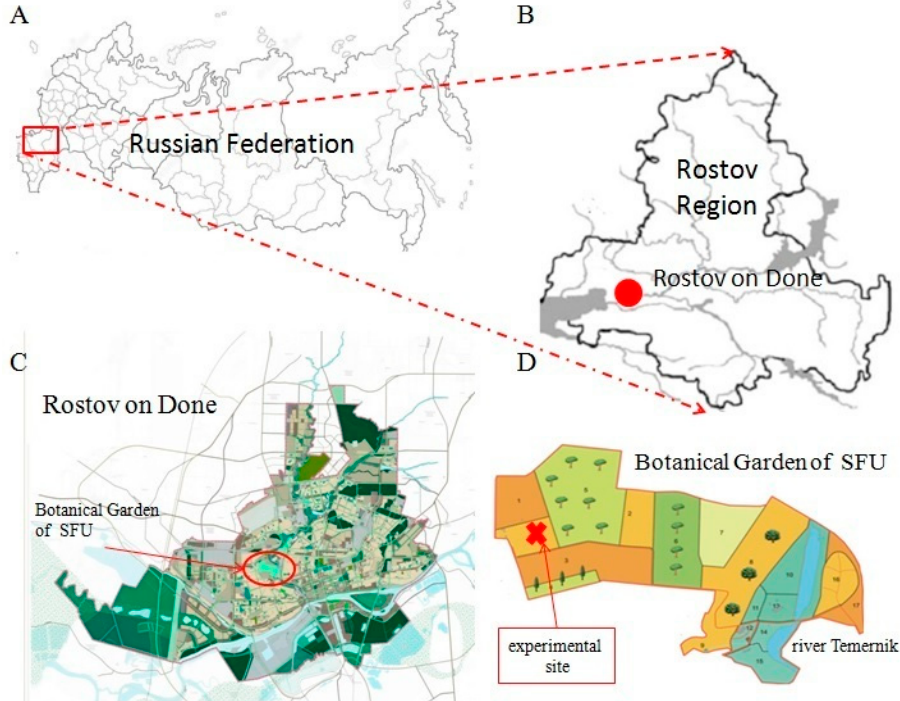
Figure 1. Map diagram of the location of the sampling site of the Botanical Garden of Southern Federal University (SFU). Note: ( A ) Rostov region as a sampling region on the map of Russia; ( B ) location of the city of Rostov-on-Don in the Rostov region; ( C ) location of the Botanical Garden of SFU on the map of Rostov-on-Don; ( D ) areal zoning of the Botanical Garden of SFU.